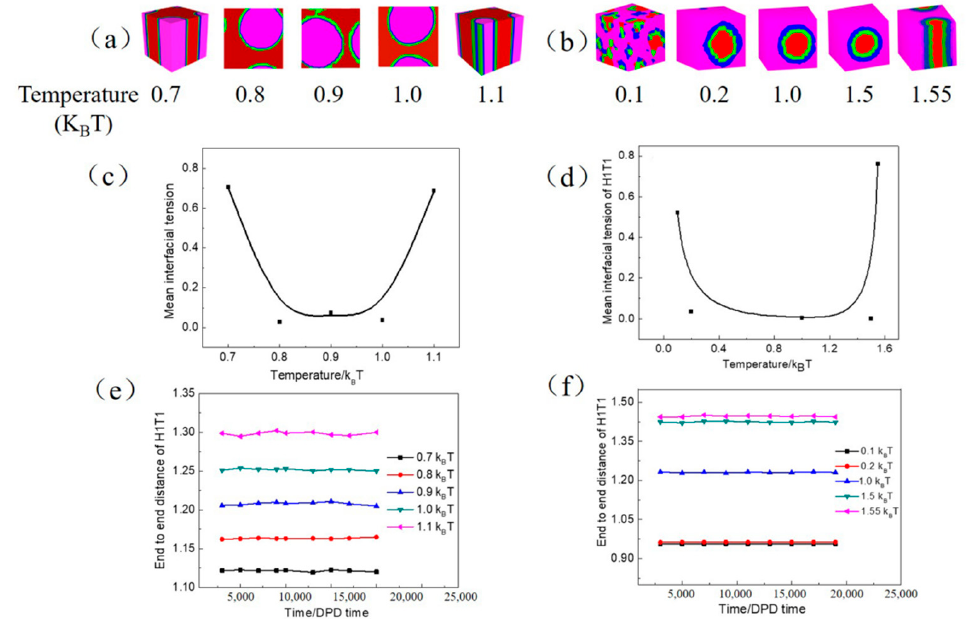
Figure 6. The translucent three-dimensional structure of microemulsion—( a , b ), the corresponding mean interfacial tension—( c , d ) and end to end distance of H1T1—( e , f ) with increasing temperature. In which, ( a , c , e ) represent O/W microemulsion, ( b , d , f ) represent W/O microemulsion.